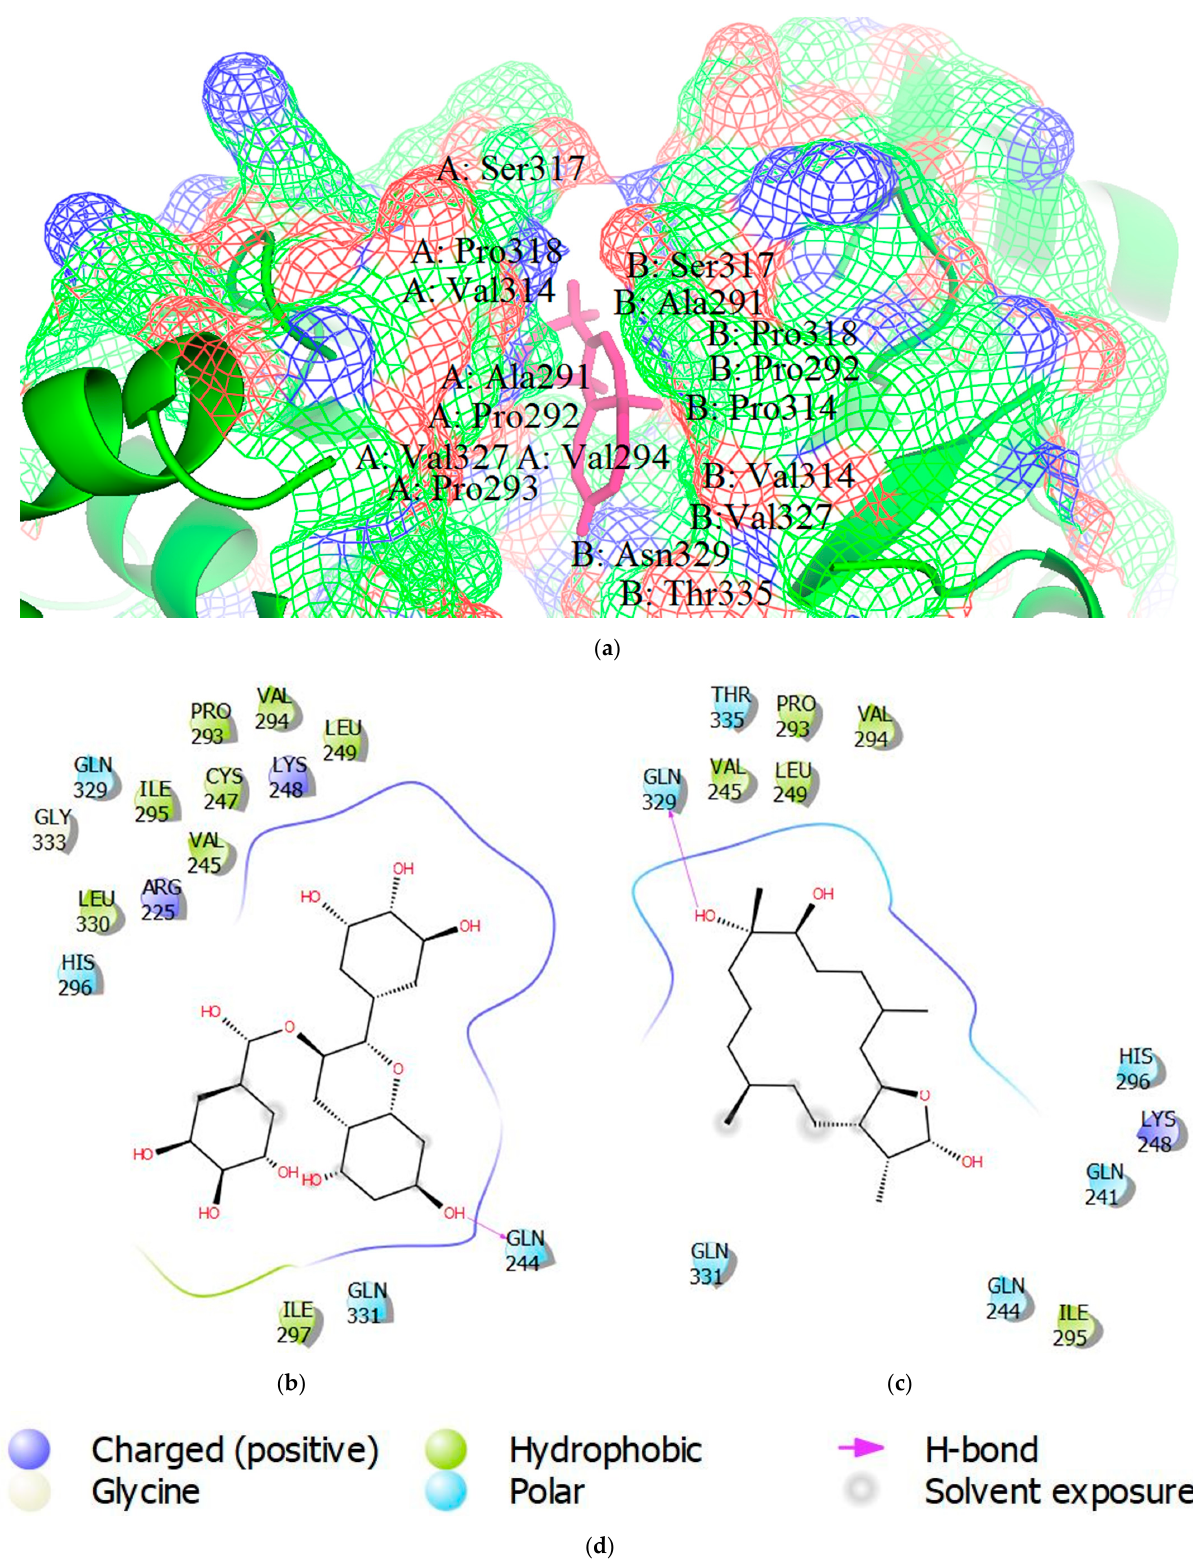
Figure 4. ( a ) A cartoon diagram of EBOV VP35 in complex with ZINC000095486250 depicting the mesh representation of the binding pocket, ( b ) 2D representation of EGCG showing molecular interaction with VP35. The hydrogen bond formed with Gln244 is colored purple, ( c ) 2D representation of NANPDB86 showing molecular interaction with VP35. The hydrogen bond formed with Gln329 is colored purple and ( d ) the legend for the protein-ligand interaction profiles.